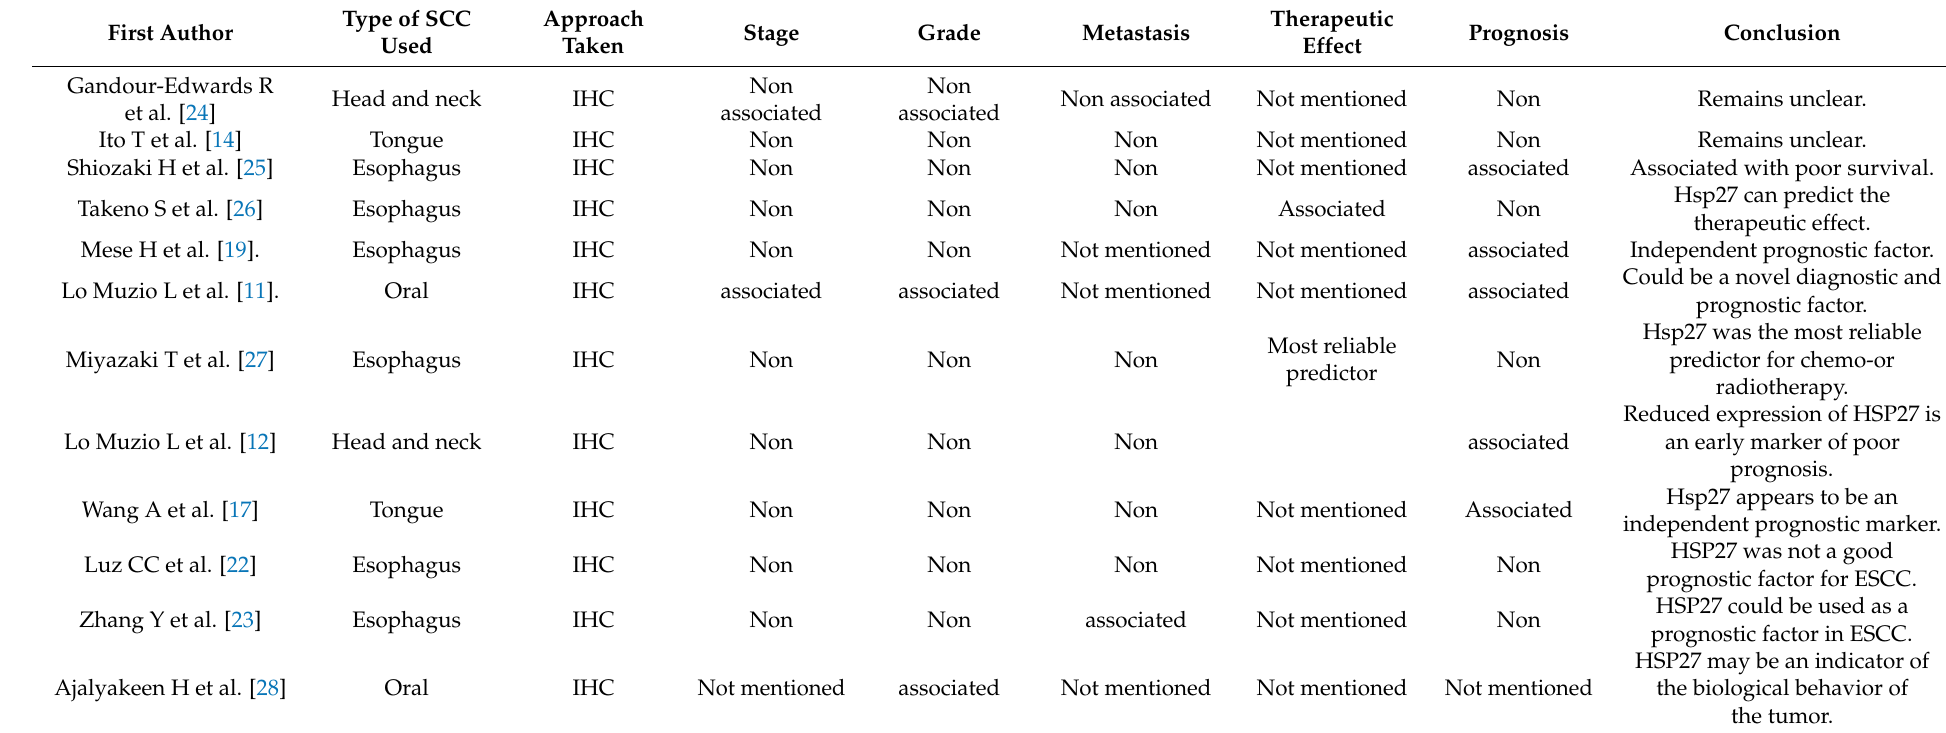
Table 2. Clinicopathological and prognostic significance of HSP27 in